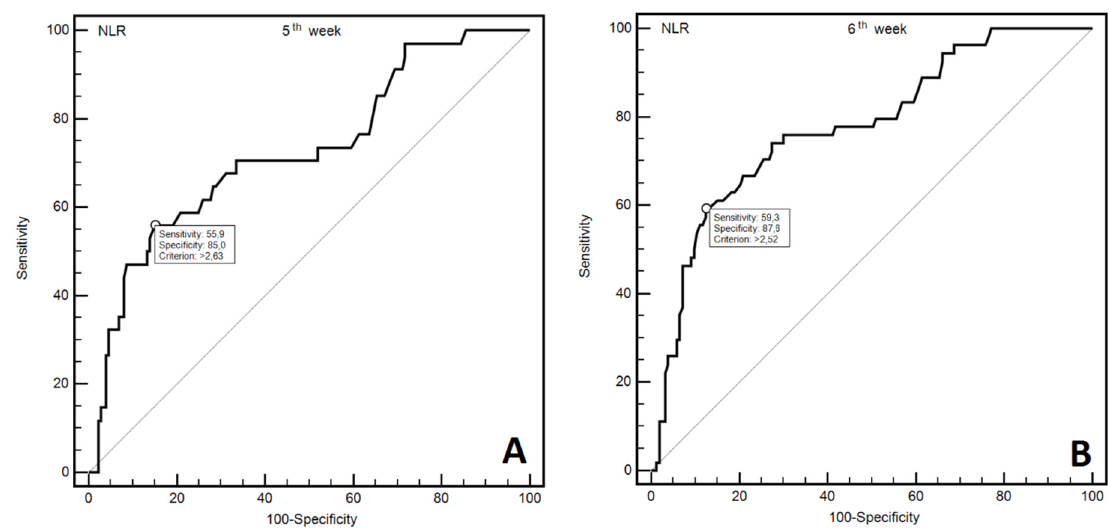
Figure 2. ROC curves representing diagnostic usefulness of NLR in prediction of more severe OM in 5th ( A ) and 6th ( B ) week of RT.